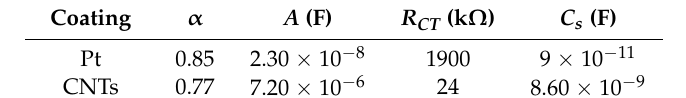
Table 3. Fitting results from the EIS model.